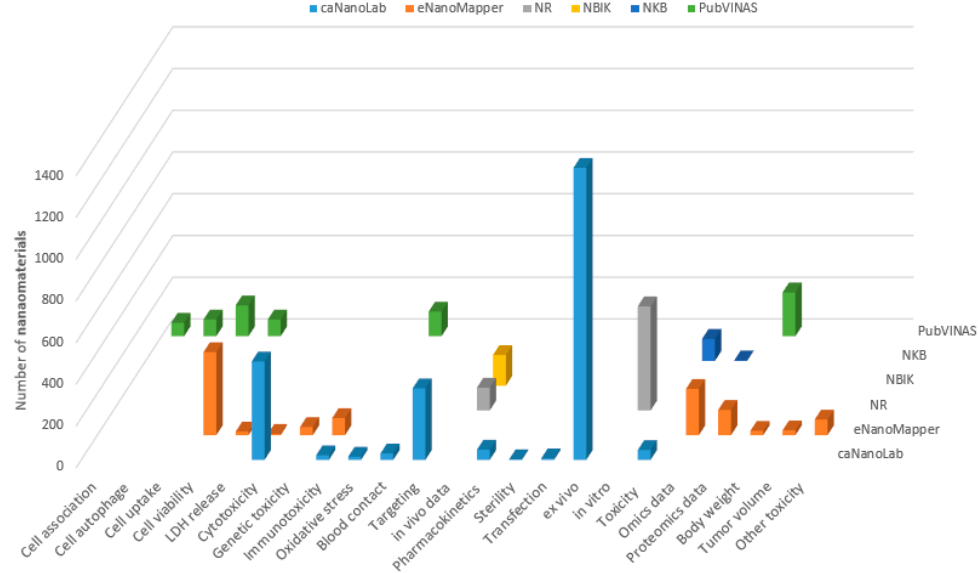
Figure 5. Number of nanomaterials ( z -axis) with biological activity data (indicated on the x -axis) in the six databases (depicted in different colors and marked on the y